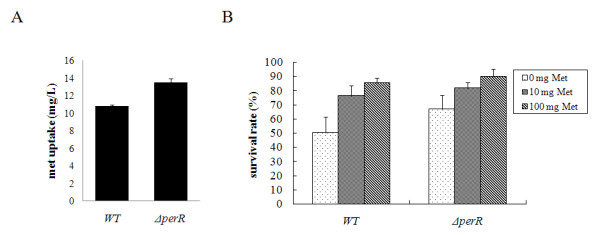
Roles of methionine in the H2O2resistance. (A) The amount of uptaken methionine in the wild type (WT) and ΔperR in cells grown to late-log phase. (B) The effects of the methionine to H2O2 resistance. Survival rates of wild-type (WT) and ΔperR in CDM with 5 mM of H2O2 challenge for 30 min. 0, 10 and 100 mg/l of methionine were added in the methionine-free basal CDM respectively.